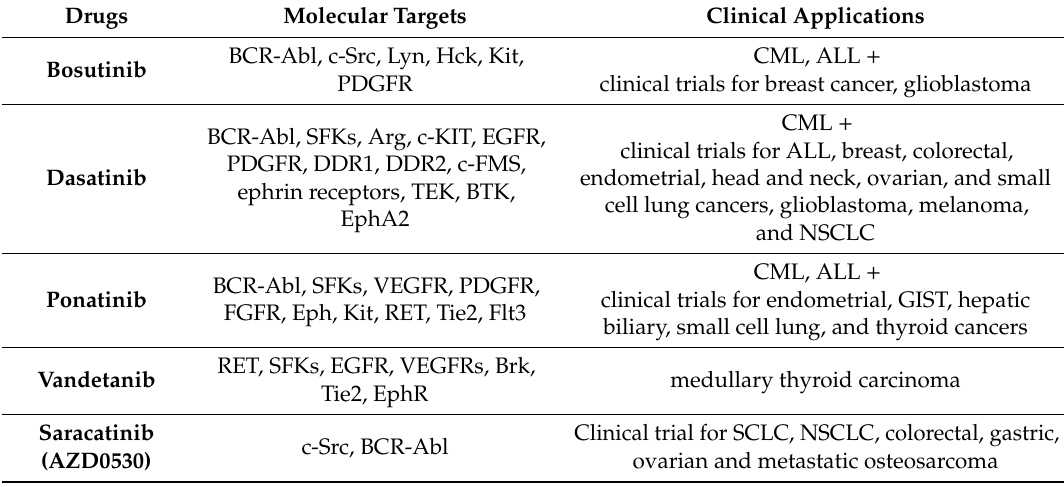
Table 1. c-Src ATP competitive